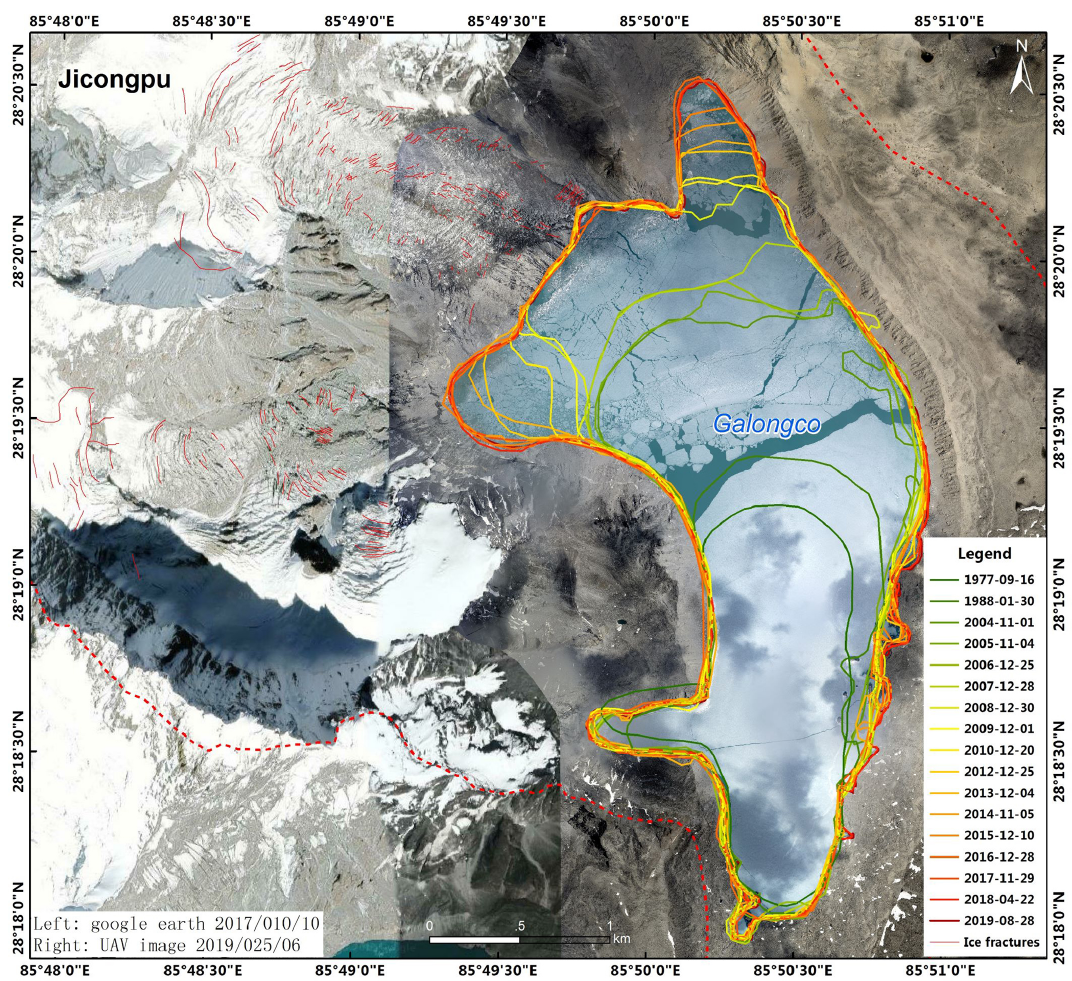
Figure 9. The variation in the area of Galongco Lake (1977–2019). The left image is from Google Earth, and the right image (overlain) of the Galongco Lake is from a UAV